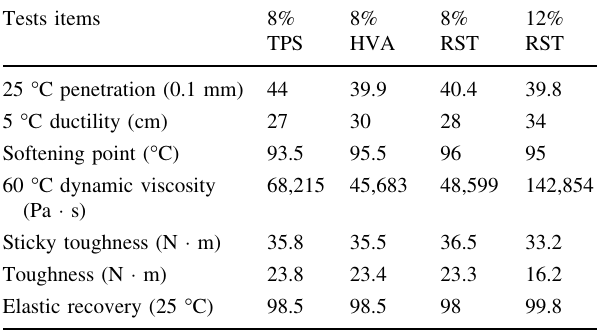
Table 9 A-type SBS asphalt binder high-viscosity performance